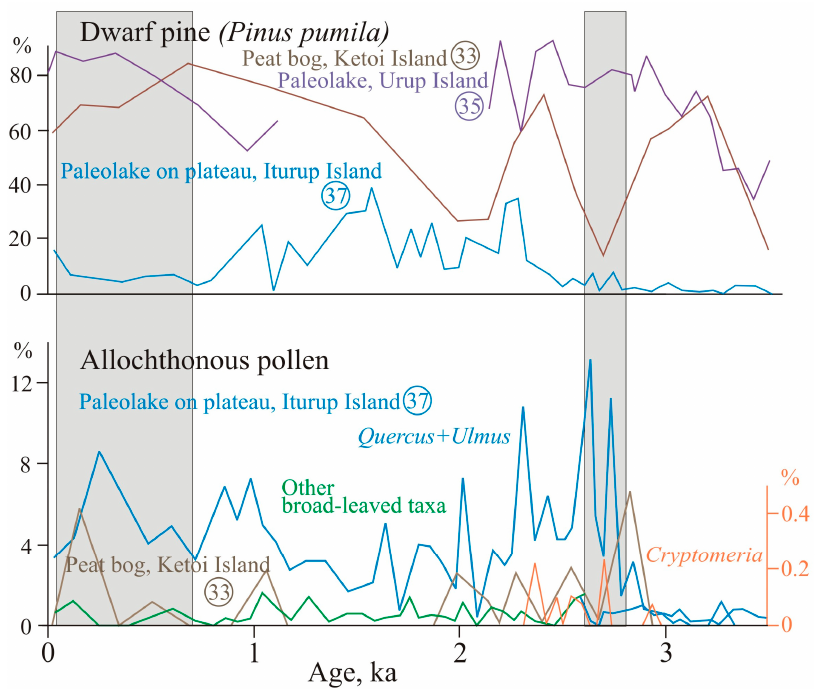
Figure 7. Comparison of results for pollen from peat bog and paleolake sequences on Kuril Islands: Pinus pumila pollen is an indicator of snowfall and winter cyclogenesis activity; allochthonous pollen from sediments of paleolake on mountain plateau (400 m a.s.l.) on the Iturup island, including Quercus and Ulmus pollen, were windblown from lower landforms; other broadleaved pollen ( Carpinus , Tilia , Juglans , Corylus , Fagus ) and Cryptomeria , that were transported from the south of both the Kurils and Japanese islands, are indicators of cyclone activity during spring–summer. Grey bars indicate 2800–2600 year BP cold event and the LIA. Numbers of sites according to Figure 2.